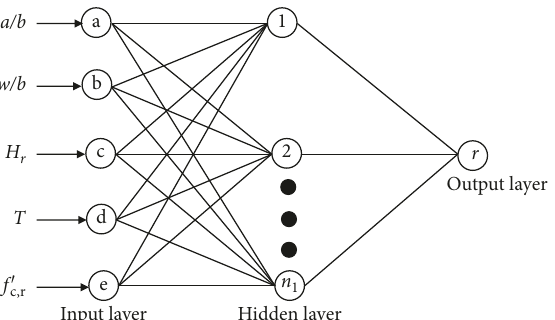
Figure 4: Neural network model involving single hidden layer employed for sensitivity analysis ( n